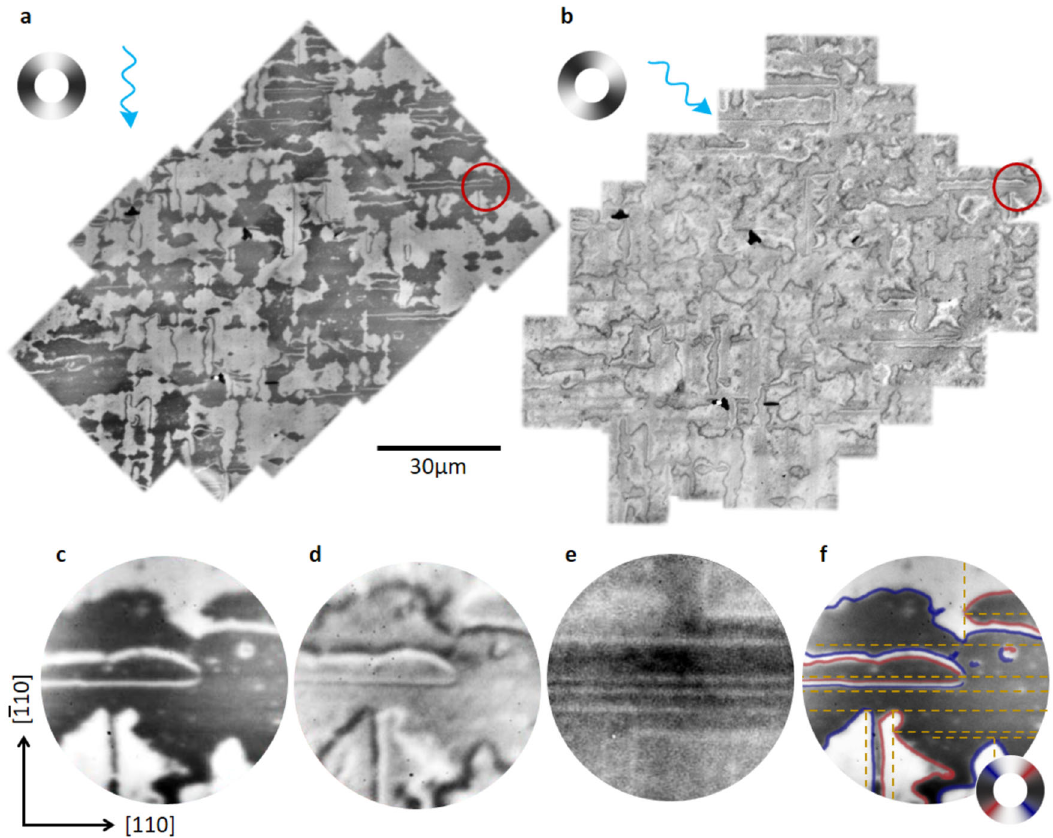
Fig. 1 AF domains and domain walls. a XMLD-PEEM image showing AF domains with spin axes parallel to [110] (dark areas) or ½ (cid:1) 110 (cid:2) (light areas). b XMLD-PEEM image for the same area as ( a ) showing AF domain walls with spin axes parallel to [100] (black lines) or [010] (white lines); the contrast in the domains appears gray. The greyscale wheels indicate the local spin axis in each image and the blue arrows represent the incident X-ray direction. The diameter of the red circle is 12.5 μ m. c High-resolution XMLD-PEEM image of the domains from the circled area in ( a ). d High-resolution XMLD-PEEM image of the domain walls from the circled area in ( b ). e High-resolution XLD-PEEM image of the same area as in ( c ) and ( d ) showing lines arising from defects. f Composite image showing the relationship between the XMLD-PEEM and XLD-PEEM images. The black and white areas show the magnetic domains, solid red and blue lines show the domain walls with the orientation indicated by the color wheel and the broken yellow lines represent the structural defects revealed by